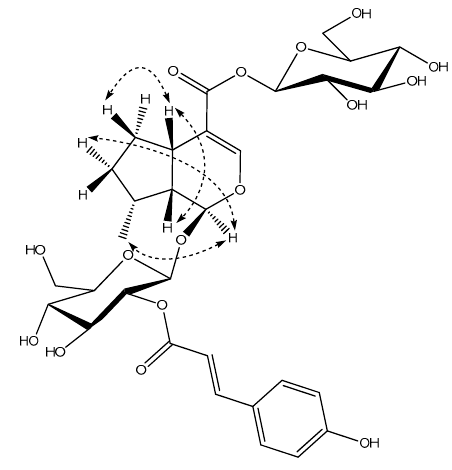
Figure 5. Selected NOESY correlations for compound 5 .